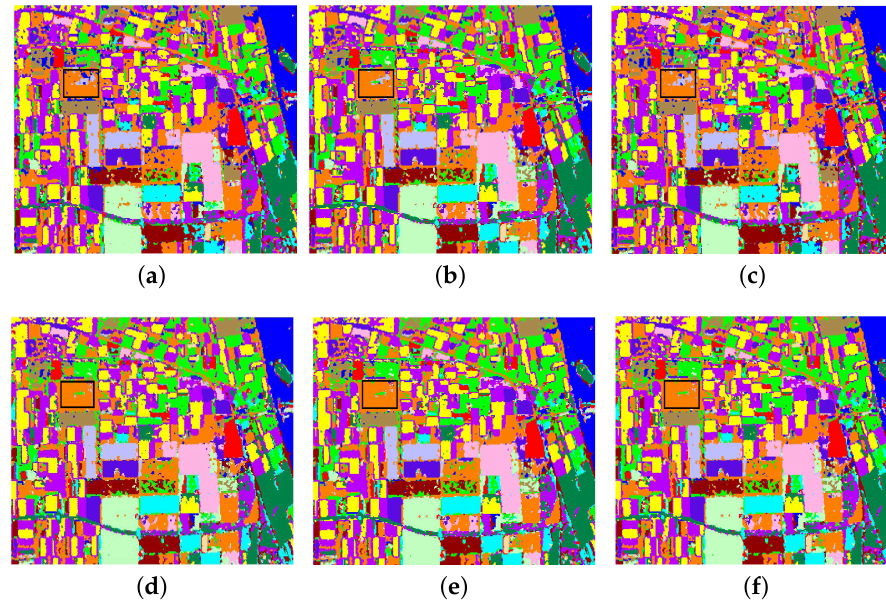
Figure 7. The classification results of our algorithms and compared algorithms. ( a ) WAE. ( b ) WCAE. ( c ) RV-CAE. ( d ) FFS-CNN. ( e ) CV-CAE. ( f )